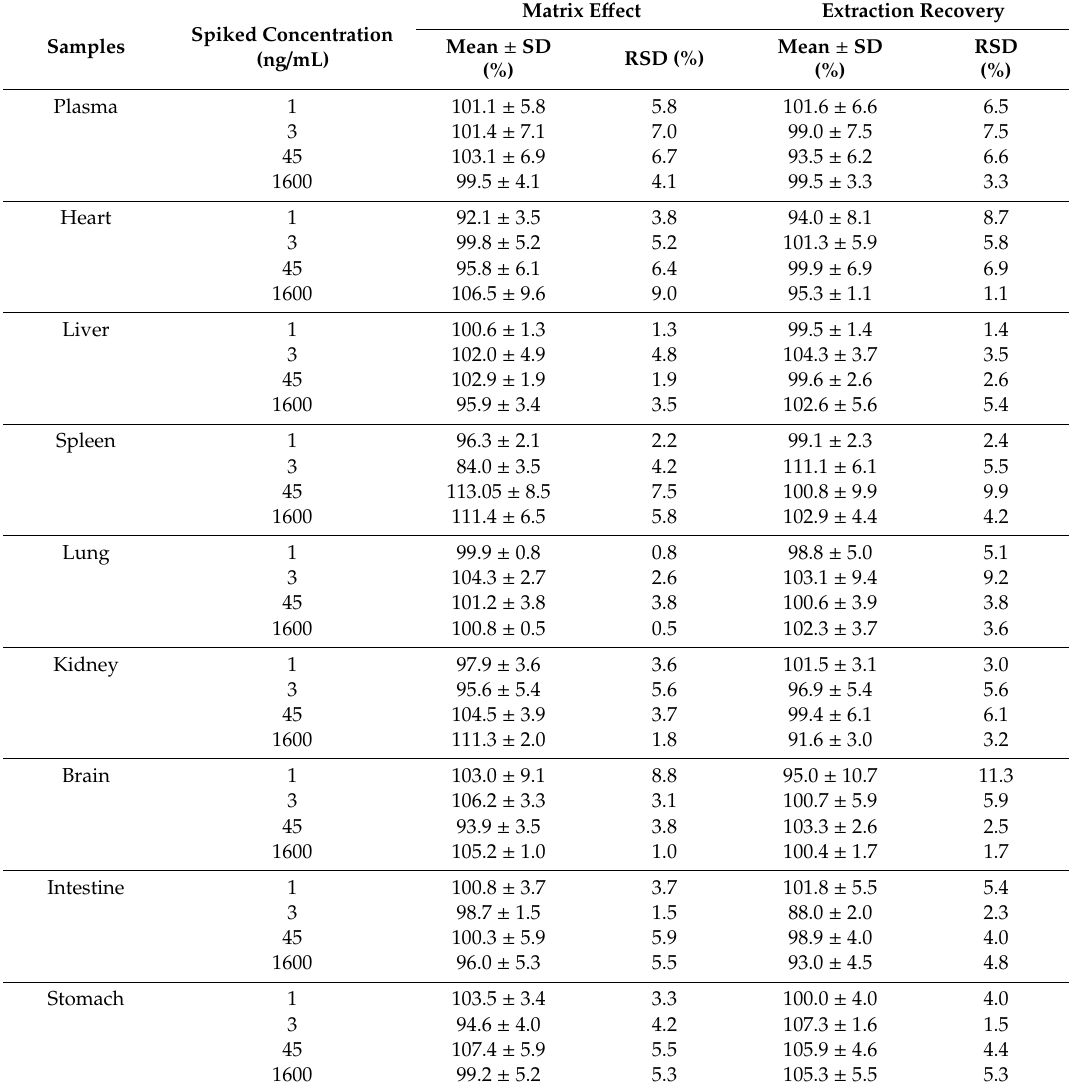
Table 4. Matrix e ff ect and extraction recovery of gardneramine in rat plasma and tissue homogenates ( n =